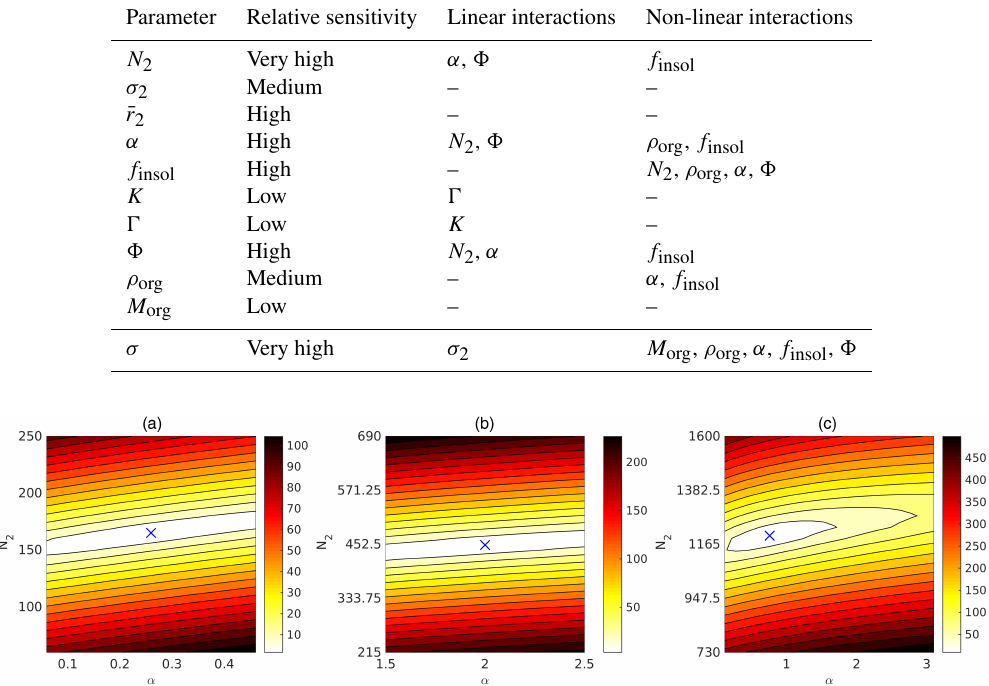
Figure 11. N 2 vs. α response surfaces of the OF for the a p w σ nf partitioning scheme in the (a) marine average, (b) rural continental, and (c) polluted continental environments. Blue crosses indicate true parameter